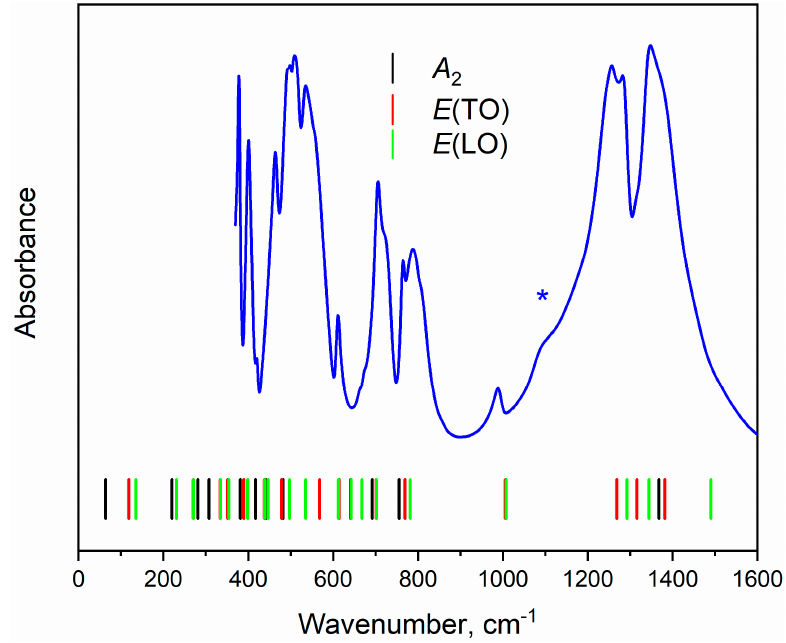
Figure 7. Infrared absorption spectra of YAl 3 (BO 3 ) 4 in Mid-IR sub region, and the artefact is shown with an asterisk. Vertical lines show the positions of calculated IR-active bands.